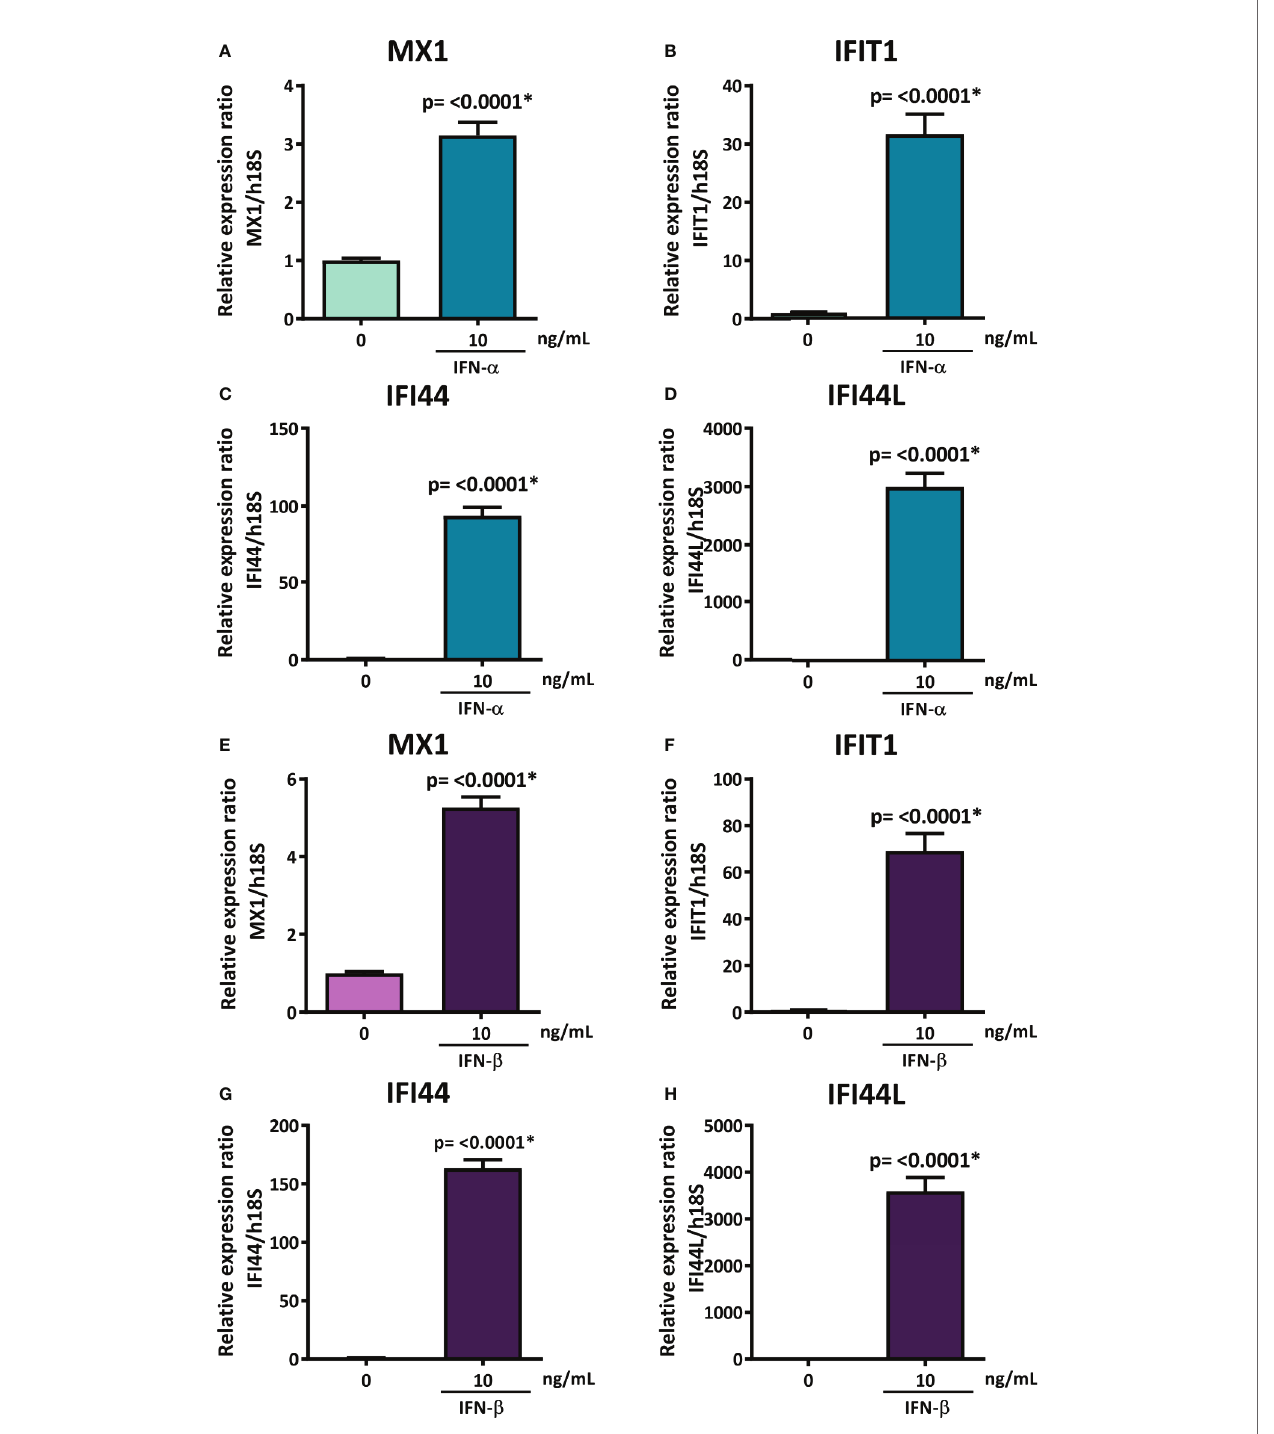
FIGURE 4 | Overexpression of MX1, IFIT1, IFI44, and IFI44L in IFN- a or IFN- b -stimulated HSG cells. Relative expression ratios of MX1 (A) , IFIT1 (B) , IFI44 (C) and IFI44L (D) in HSG cells stimulated with or without 10 ng/mL human recombinant IFN- a for 24 h. h18S was used as a housekeeping gene. Relative expression ratios of MX1 (E) , IFIT1 (F) , IFI44 (G) and IFI44L (H) in HSG cells stimulated with or without 10 ng/mL human recombinant IFN- b for 24 h. h18S was used as a housekeeping gene. Data are representative of at least three independent experiments. (*) p-value ≤ 0.05 was considered signi fi